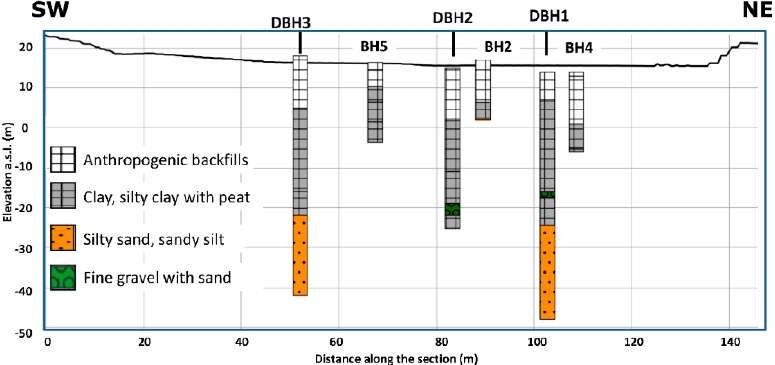
Figure 21. Borehole data projected along the trace of section crossing SW-NE in the study area.